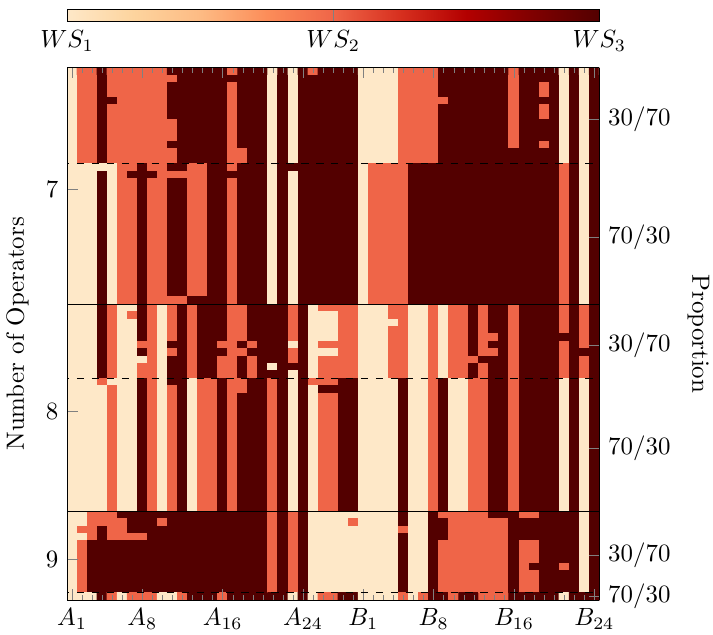
Figure 6. Task allocations from the non-dominated solutions from all scenarios in the initial optimizations.